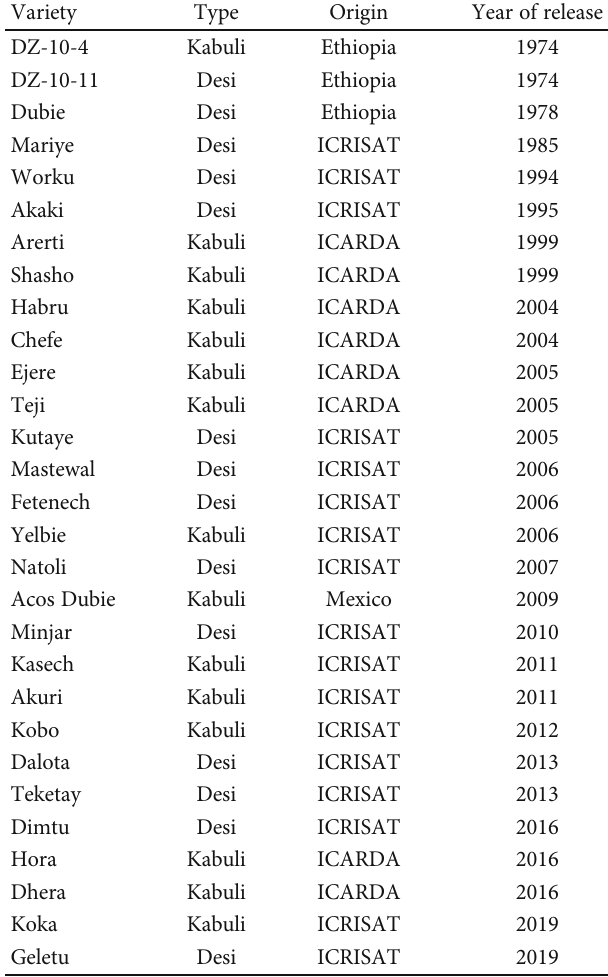
Table 1: Top chickpea-producing countries in the world from 2013 to 2017.